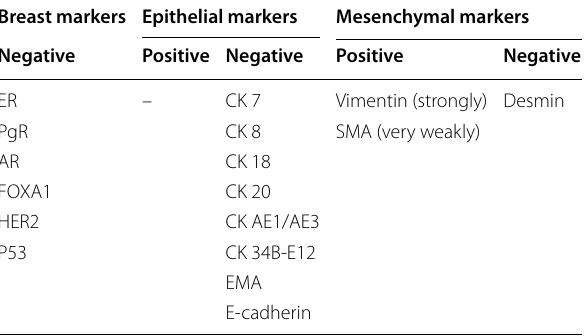
ER estrogen receptor, PgR progesterone receptor, AR androgen receptor, FOXA1 Forkhead box protein A1, HER2 human epidermal growth factor receptor2, CK cytokeratin, SMA smooth muscle actin